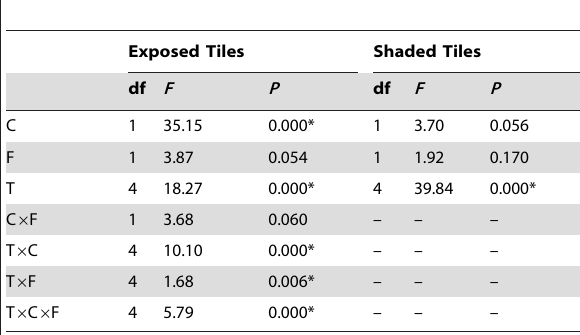
Bottom-Up & Top-Down Effects on Red Sea